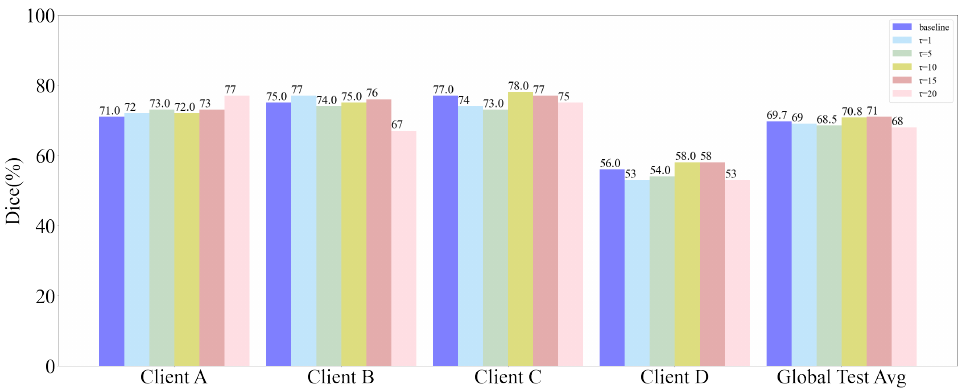
Figure 9. Visualization of the effect of different distillation temperatures on the training results.